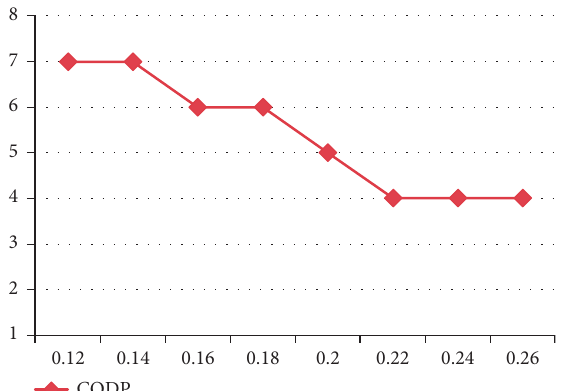
Figure 14: The optimal CODP when λ changes from 0.12 to